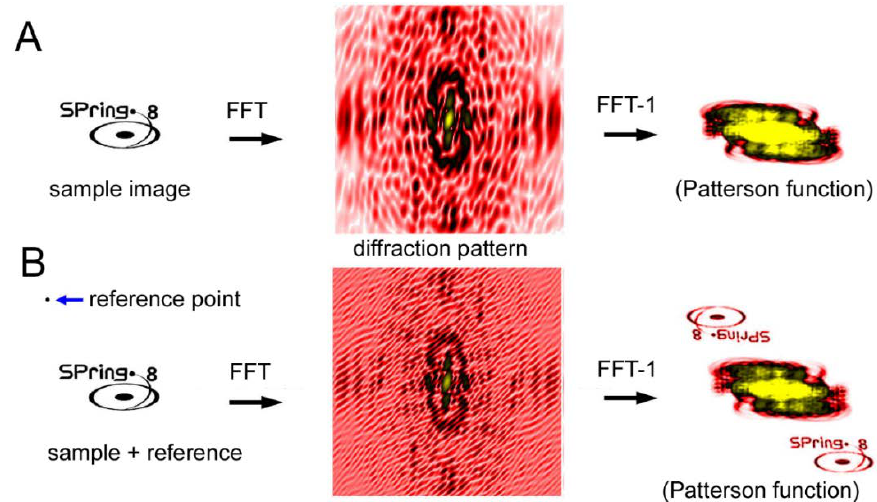
Figure 10. Principle of Fourier transform holography (FTH). ( A ) Diffraction from a sample (SPring-8 logo) and its inverse Fourier transformation (FFT − 1 ) calculated by assuming that the phases are all zero. This results in what is called the Patterson function, which is an autocorrelation function of the sample. This is a real-space image but it is very difficult to imagine what the sample looks like by watching this function. ( B ) Diffraction from a sample with a reference point. The phase information is preserved in the Moir é pattern (caused by the interference between the sample and the reference) and, as a result, the real-space image of the sample is restored by performing inverse Fourier transformation. This is an experiment on a